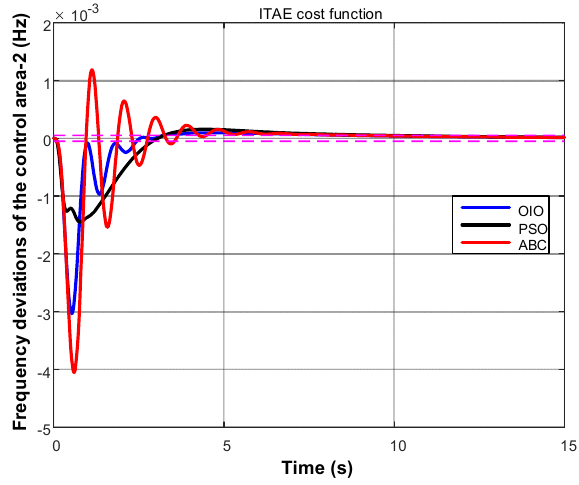
Figure 7. Change in frequency of area ‐ 2 for ITAE. Energies 2017 , 10 , 2134